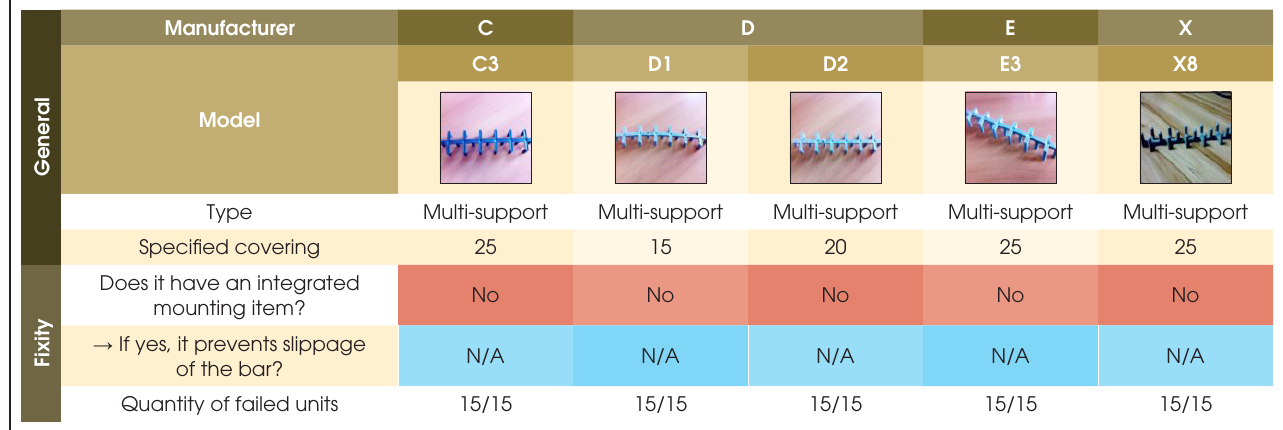
Table 12 – Results of the fixity requirement evaluation of the multi-support-type spacers of the manufacturers C, D, E and unknown manufacturers